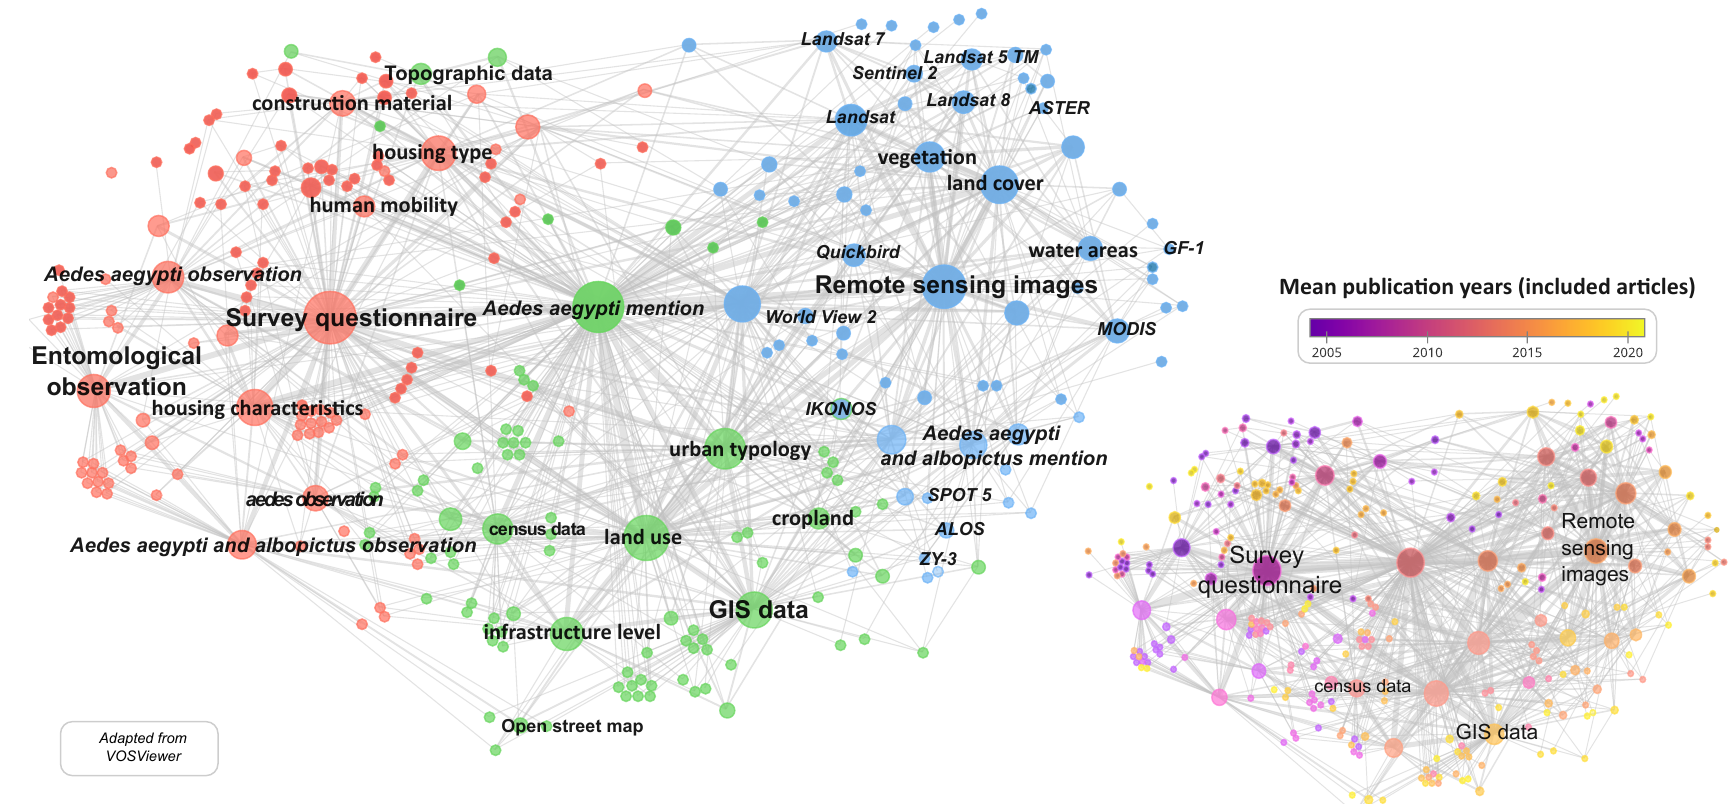
Figure 4. Keywords co-occurrences network associated to the 78 included articles, clustered by data sources ( left ), and year of publication ( right ). Nodes without labeling refer to landscape factors, which are detailed in the following network and sections. Nodes in italics refer to the type of the data acquisition